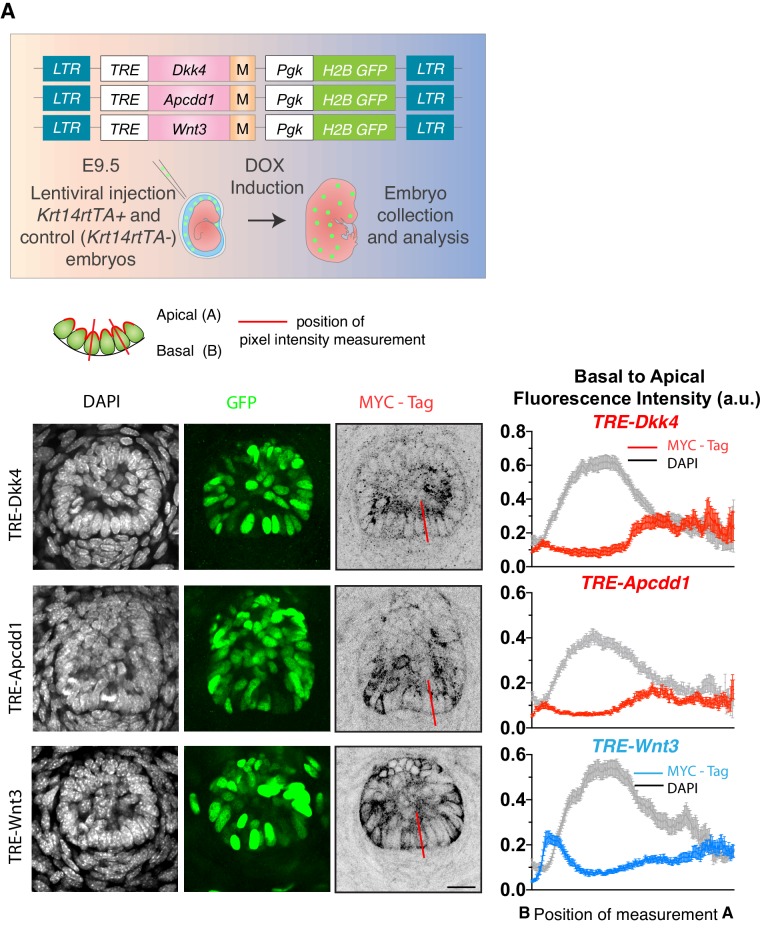
Differential polarization of WNT inhibitors and activators.Strategy to monitor WNT inhibitors (DKK4 and APCDD1) and ligands (WNT3) by MYC-epitope tagging (M). LV-constructs were introduced into the amniotic cavities of E9.5 Krt14rtTA embryos, and transduced genes were activated by doxycycline (DOX). Whole-mount immunofluorescence and/or immunohistochemistry of representative images of hair buds are shown below. DAPI to label chromatin; anti-GFP to mark nuclei of transduced cells; Anti-MYC-tag to label the expressed inhibitor/ligand. At right are shown the basal-apical MYC-Tag pixel intensity profiles, which were measured along the lines presented in the overlying schematic of the WNThi progenitor cells of the hair follicle. A minimum of 40 WNT-signaling progenitor cells were analyzed and averaged to develop these profiles. Note the preferential apical enrichment of DKK4 and APCDD1 and opposing basal enrichment of WNT3 signal. Mean ± SEM. a.u., arbitrary units. All scale bars 20 μm.Figure 5—figure supplement 3—source data 1.Source data for the graphs shown in Figure 5—figure supplement 3A.